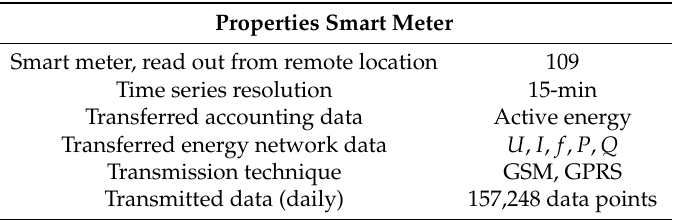
Table 1. Properties of the dataset.